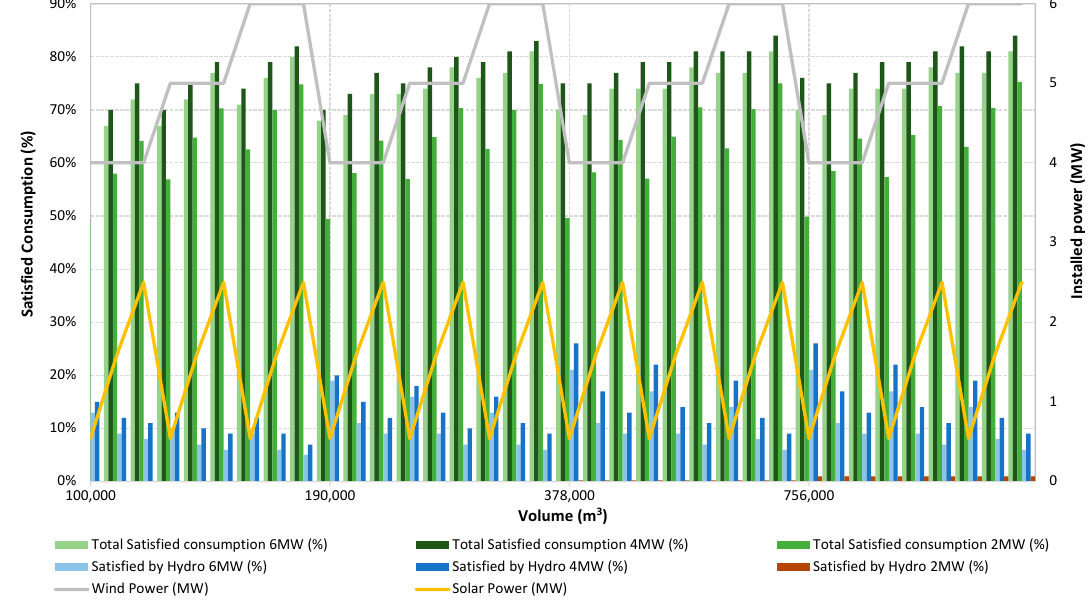
Figure 6. Satisfied consumption (wind + solar + hydro; hydro) using P/Ts with 6, 4 and 2 MW.